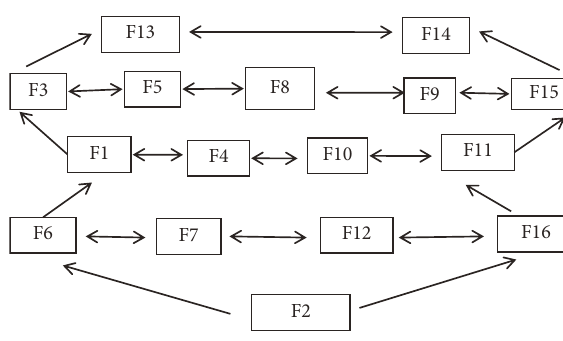
Figure 2: ISM-based model for